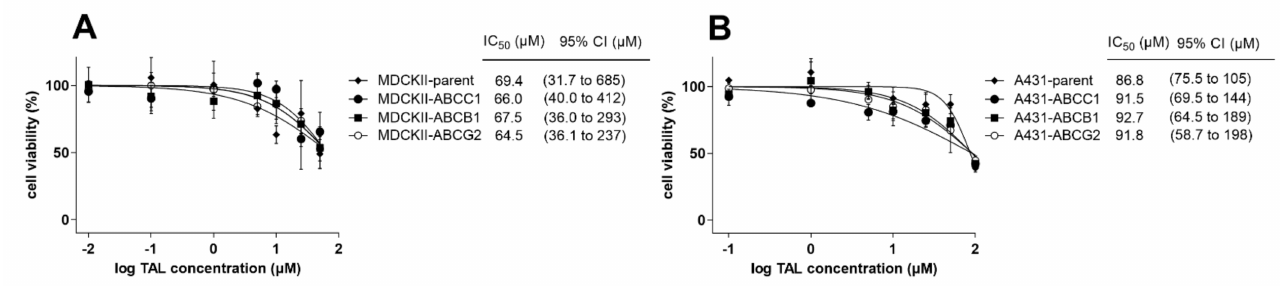
Figure 8. Talazoparib shows comparable antiproliferative effects within ( A ) MDCKII and ( B ) A431 cellular sublines. The cells were exposed to serial dilutions of talazoparib for 48 h, which was followed by viability detection using the MTT proliferation assay. The two-tailed unpaired t -test was applied to statistically compare the IC 50 values from parental cells and their transporter-expressing sublines. However, we did not find any statistically significant differences in either of the cell models. The values in the graphs are means ± SD, which were generated in three independent experiments. TAL, talazoparib.